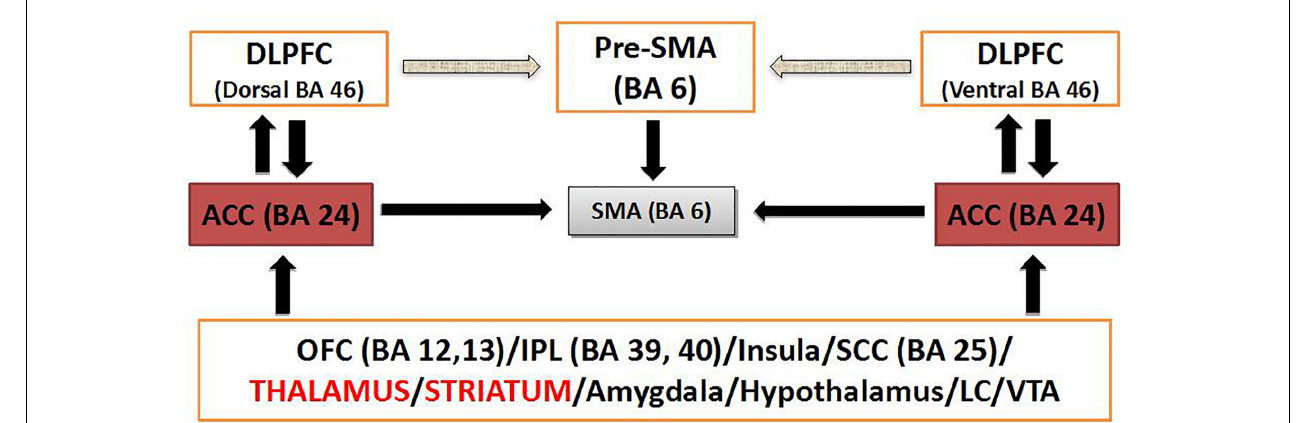
BOX 2 | Cognitive control and the potentiality of targeting the dACC. Within the RDOC construct of cognitive control and, more specifically the subdomain of response inhibition/response selection, the neural network of the anterior cingulo-insular or salience network (aCIN) seems to be critically relevant (Downar et al., 2016). The dACC stands midway along a hierarchy of medial prefrontal regions that guide goal selection, thought selection and action selection based on internal drives as opposed to external cues. The dACC is active when choosing freely between to different cognitive tasks and during voluntary internally cued modulation of emotional state (Downar et al., 2016). The anterior cingulate cortex (ACC) interfaces attention, executive function, drive, affect and motor control. Convergent data from neuroimaging, neuropsychological, genetics, and neurochemical studies have implicated, bilaterally, dysfunction of dorsolateral prefrontal and anterior cingulate cortical structures, which constitute the cortical arm of the frontostriatal network (caudate and putamen being its subcortical counterpart) driving executive function (Solanto, 1984; Castellanos, 1997; Zametkin and Liotta, 1998; Giedd et al., 2001; Seidman et al., 2006; Makris et al., 2007), in cognitive dyscontrol. The ACC (Brodmann’s area 24 or BA 24) is an important regulator of other cortical and subcortical brain regions as well, and its disconnection appears to be consistent with an executive dysfunction. The ACC is connected with other cortical areas ipsilaterally and controlaterally as well as with subcortical structures. The topographic organization of these axonal connections is precise within the subcortical white matter and architectonically arranged within the overlaying cortical layers of the ACC ( Figure 1 ). This mesh of connections converging to and diverging from the neuronal bodies of the ACC constitutes a central networking node within the overall connectional map of the brain crucial for the interface of drive, emotion, cognition and motricity (Paus, 2001) as well as for the modulation of cognitive control (Cohen et al., 2000). Short (U-fibers) and medium range association fibers connect BA 24 with adjacent cortical areas. The more complex long association fibers belong to three discrete fiber bundles, namely the cingulum bundle (CB) (Mufson and Pandya, 1984), the uncinate fascicle (UF) (Petrides and Pandya, 1988) and the extreme capsule (EmC) (Petrides and Pandya, 1988). Through these three fiber pathways the anterior cingulate cortex is connected in a bidirectional fashion as follows (Schmahmann and Pandya, 2007). The CB connects BA 24 with rostral posterior cingulate BA 23, paracingulate BA 32 and orbital frontal BA 14, 12, and 11 as well as prefrontal BA 8 and 6 (Baleydier and Mauguiere, 1980). Via the UF, BA 24 connects with subcallosal BA 25 and basal forebrain regions as well as the amygdala and the perirhinal cortex. The EmC provides connections with the dysgranular insula and the insular proisocortex. Striatal fibers by virtue of the subcallosal fascicle of Muratoff connect BA 24 to the caudate’s head and, through the external capsule, with the putamen and claustrum. Thalamic connections are with anterior, the medial dorsal as well as the midline thalamic nuclei. Other connections are with the parahippocampus, the hippocampus, the zona incerta and the pons as well as with the locus coeruleus and the ventral tegmental area (Paus, 2001). Motor connections are with the supplementary motor area, the motor cortex and the spinal cord (He et al., 1995). Chronic failure of the ACC network may have profound implications contributing to deficit of cognitive control. Convergent evidence from fMRI (Carter et al., 1998, 1999; Botvinick et al., 1999; Cohen et al., 2000) and evoked potential (Gehring and Knight, 2000) experimentation in humans suggest that ACC is associated with monitoring of conflict and modulation of cognitive control as well as modulation of allocation of attention in real time. As illustrated in Figure 1 , interactions between the dorsolateral prefrontal (DLPFC), inferior parietal lobule (IPL), orbital frontal cortex (FOC), amygdala and brainstem centers such as the locus coeruleus or the ventral tegmental area, enable the ACC to integrate sensitive information in real time to monitor conflict of competitive cognitive tasks, modulate cognitive control and produce balanced behavior (Yeterian and Pandya, 1985; Cohen et al., 2000). It appears that alterations in the ACC and its associated frontostriatal network (primarily the caudate nucleus and putamen being its subcortical counterpart), which are driving executive function, are critical in executive dysfunction. Therefore, neuromodulatory interventions seem to be an important therapeutic means to modulate ACC function and restore balance in behavior when cognitive control is lost in such conditions as